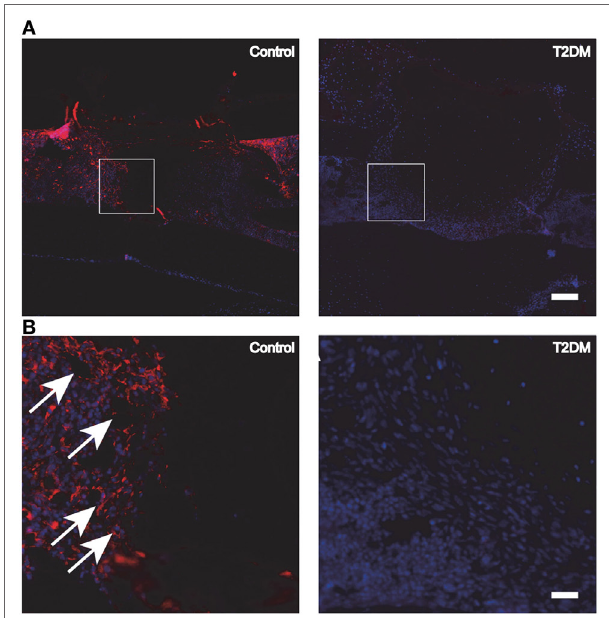
FigURe 4 | (a) Fluorescence immunohistochemistry staining for PECAM-1, to detect the presence of blood vessels and endothelial cells in control vs type 2 diabetes mellitus (T2DM) mice tibiae, 3 days post-surgery. (B) Magnification of the areas in (a) represented by white squares. White arrows signal blood vessels and endothelial cells, stained in red. White scale bar in (a) : 200 µm. White scale bar in (B) : 45 µm. Figure taken and adapted from Ref.